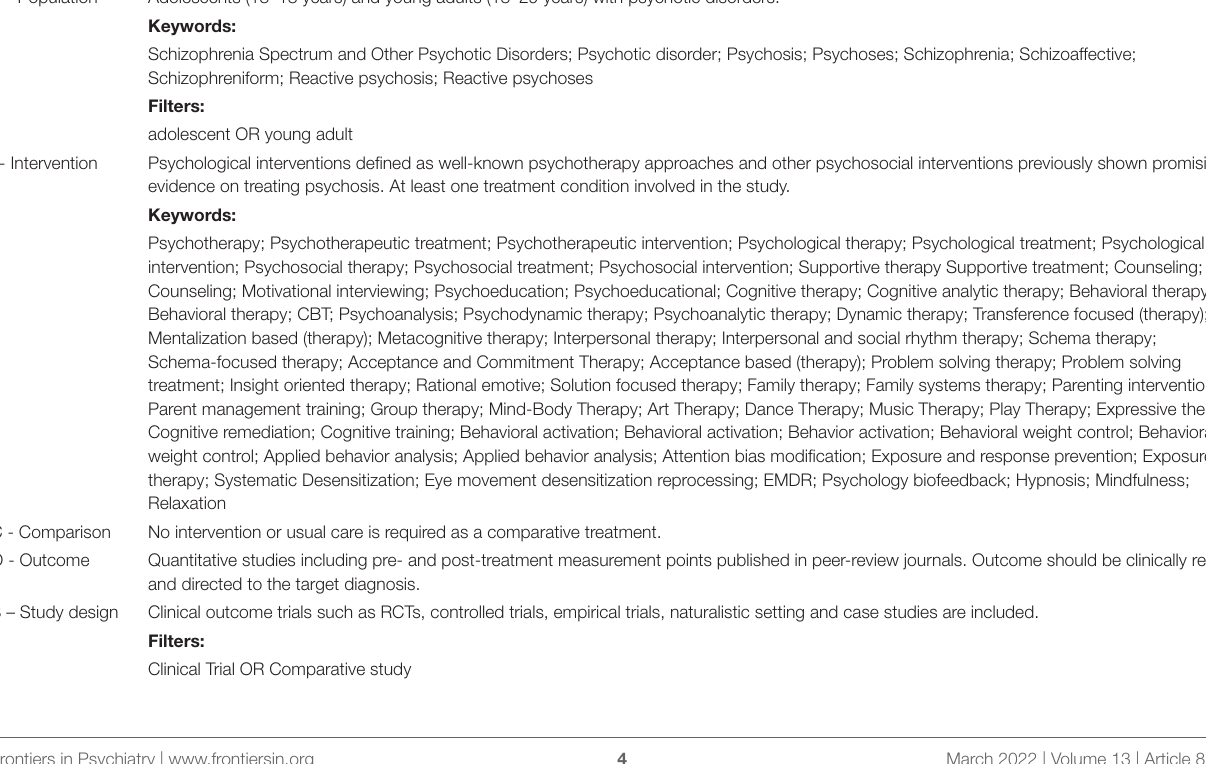
TABLE 1 | The PICOS strategy used to form the search strings for the systematic database searches. P -